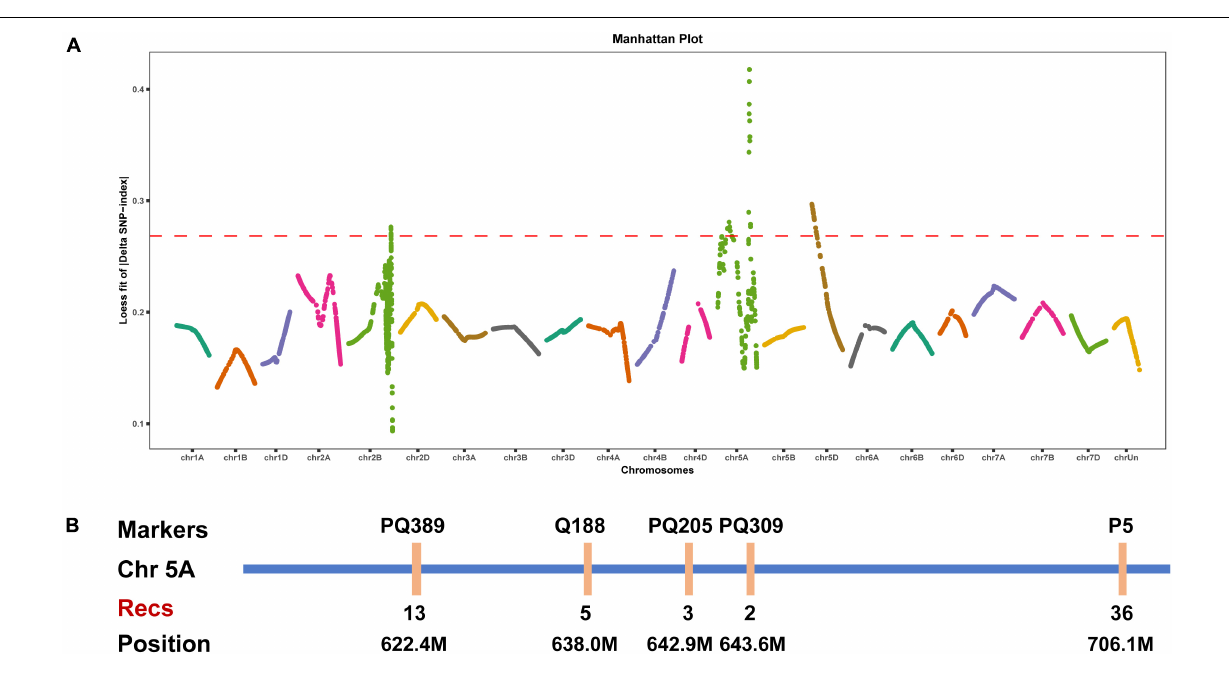
FIGURE 2 | Elucidation of the gene controlling speltoid spikes via BSA and linkage mapping. (A) Distribution of the LOESS fits of the (cid:49) SNP-index values on all chromosomes. The names of all chromosomes are shown on the x -axis, and the LOESS fits of the (cid:49) SNP-index values are shown on the y -axis. (B) Linkage map around the candidate interval. Recs indicates the